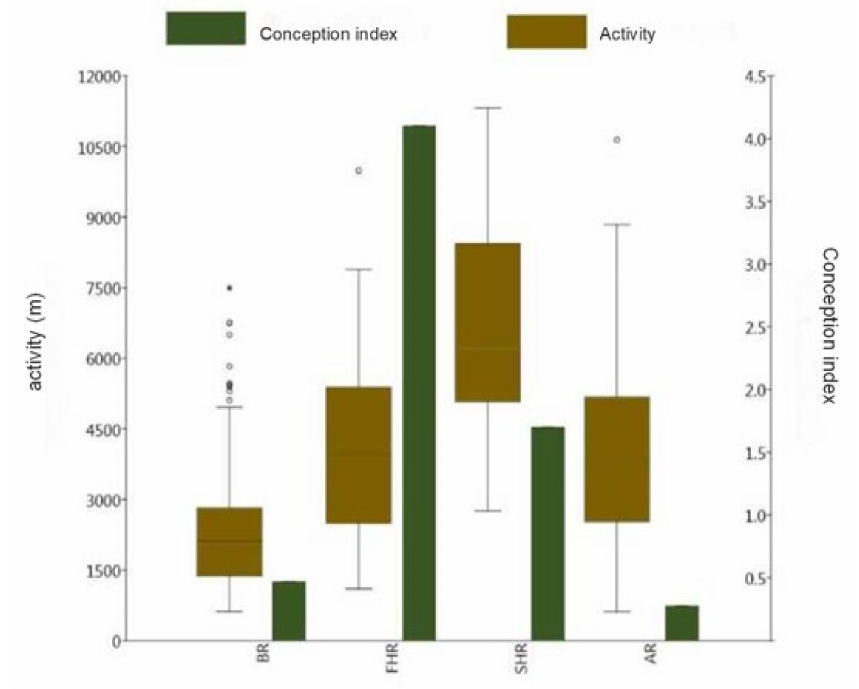
Figure 3. Activity and conception index values in the different study periods (“Before Rut” (BR), 1 August–30 August; First Half of Rut (FHR) 31 August–9 September; Second Half of Rut (SHR) 10 September–19 September; After Rut (AR), 20 September–29